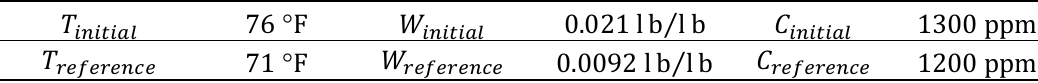
Table 2. Initial state and reference